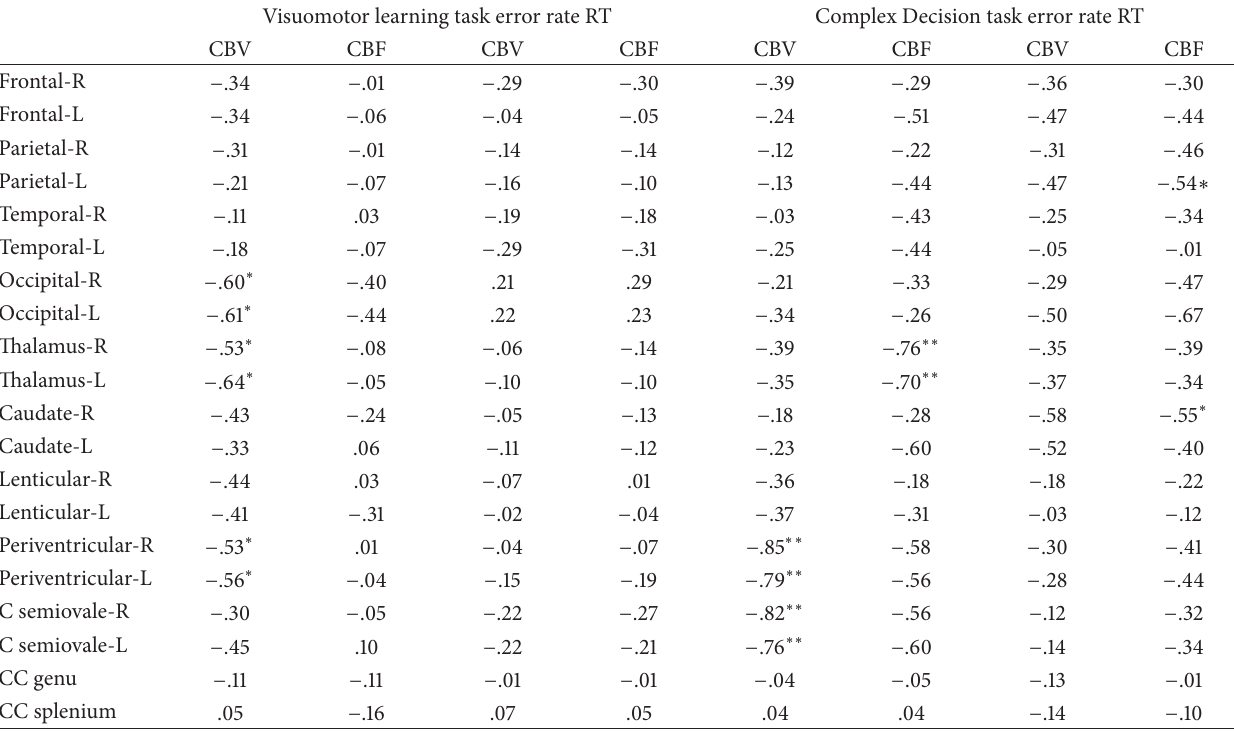
Decision tasks, respectively.